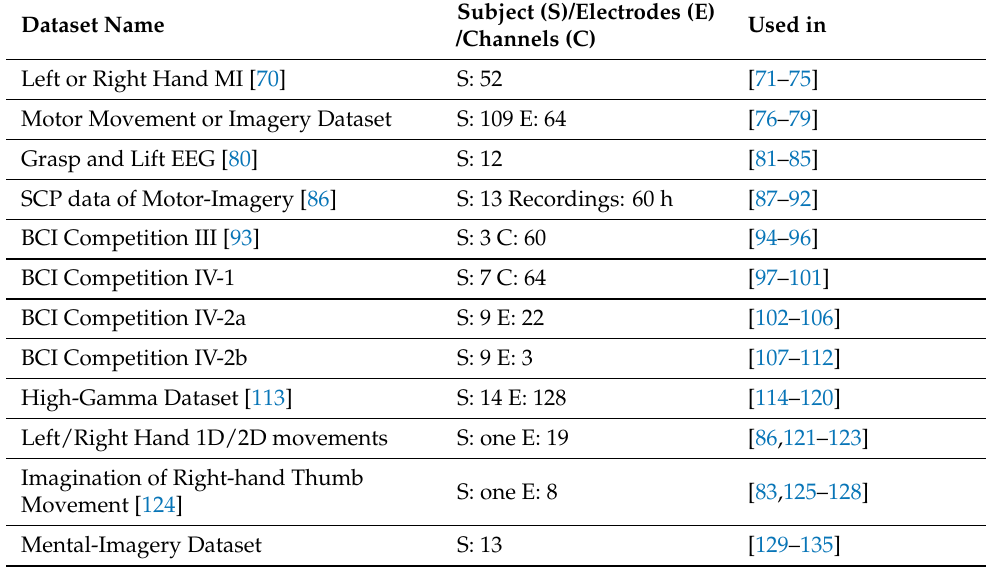
Table 2. A table of different types of motor imagery datasets of